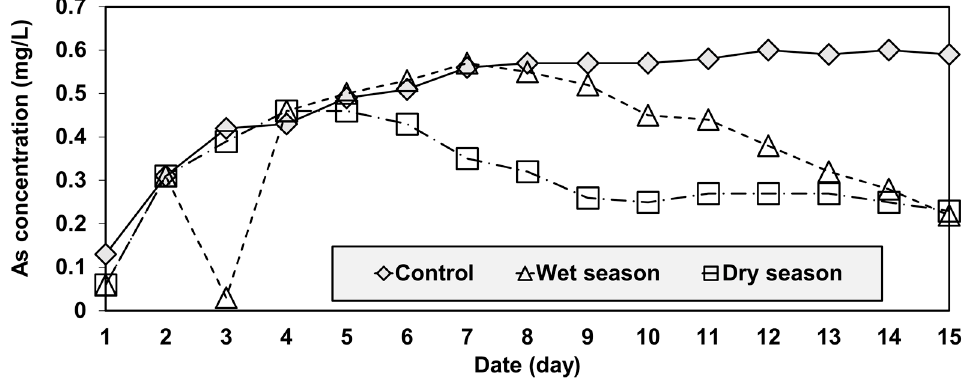
Appl. Sci. 2019 , 9 , x FOR PEER REVIEW Figure 6. Temporal variations of arsenic concentration in the reservoir. Figure 6. Temporal variations of arsenic concentration in the reservoir.